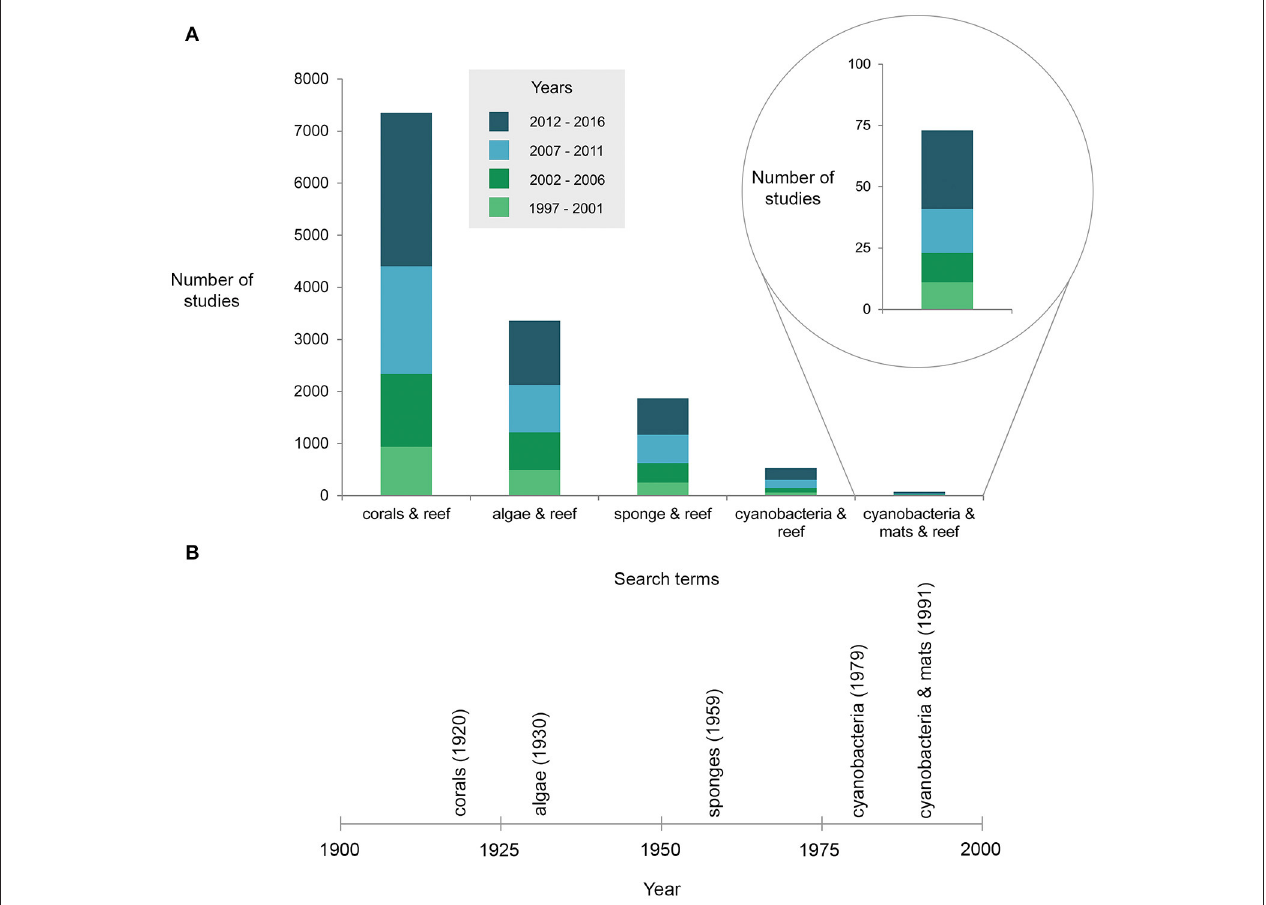
FIGURE 2 | (A) Results from a Web of Science ® search depicting the number of articles published since 1997 (displayed in five-yearly intervals) according to various coral reef associated search terms, and (B) the year of the first publication including the search terms (each term searched with